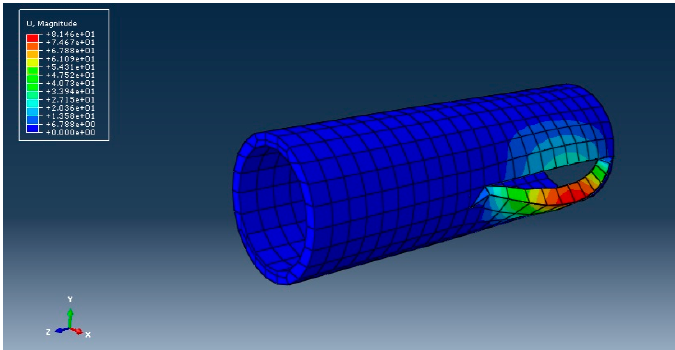
Figure 27. Crack analysis model of DN 315 pipe.